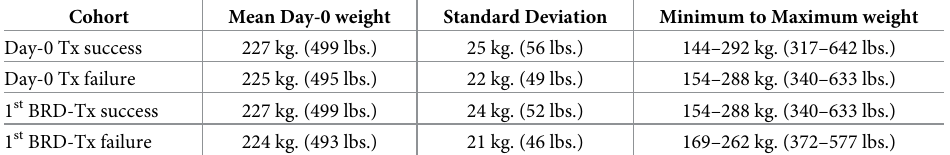
Table 1. Weight parameters of day-0 and 1 st BRD-treatment